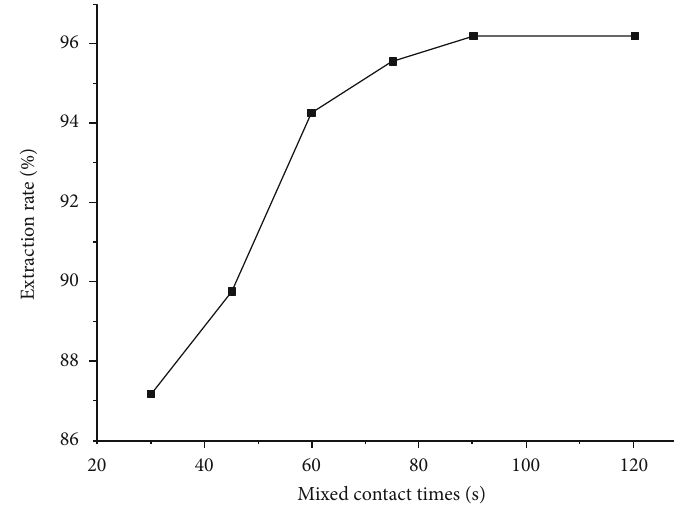
Figure 3: E ff ect of mixed contact time of organic phase and water phase on